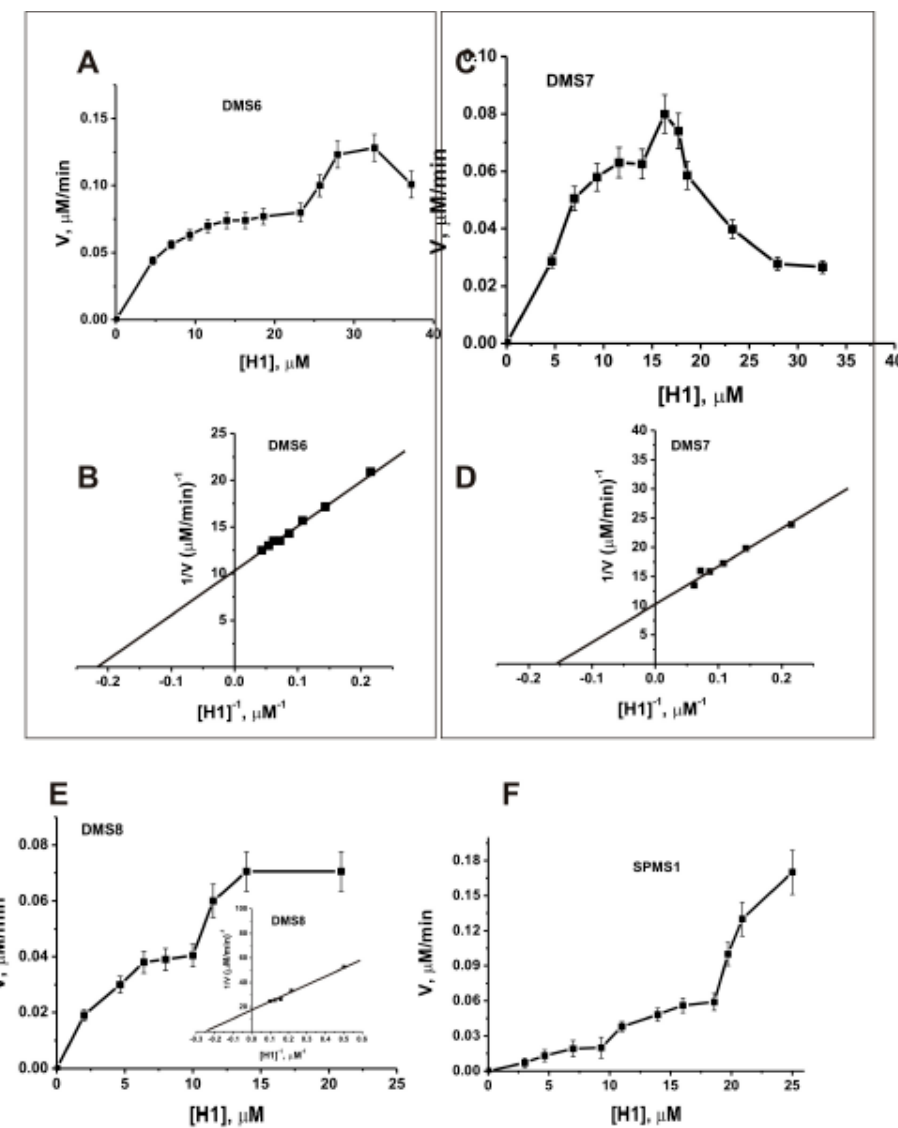
Figure 5. Dependencies of relative rates of H1 hydrolysis by di ff erent IgGs (0.33 µ M): DMS6 ( A , B ), DMA7 ( C , D ), DMA8 ( E ), and SPMS1 ( F ) in di ff erent coordinates on the concentration of H1 histone. Determination of the K m and V max values for H1 histone in its hydrolysis by DMS6 ( B ) and DMA7 ( D ), and DMA8 (insert to E ) was performed using the Lineweaver–Burk plot and the data corresponding to the first part of the hyperbolic curves of panels A and C, respectively; the insert to E corresponds to first part of the main dependence for DMA8. The error in the initial rate determination at each substrate concentration did not exceed 10–25%. Significance of di ff erences between data of A and B panels, p = 0,0005. Reactions were performed as described in Materials and Methods.